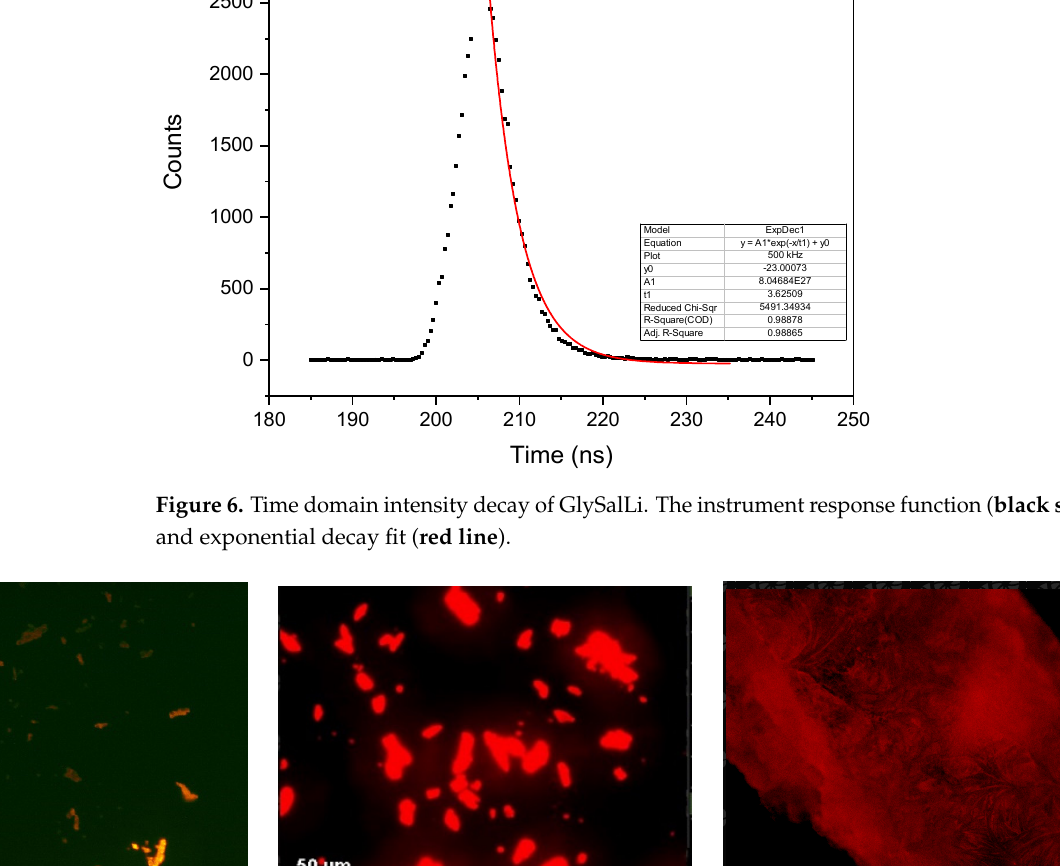
Figure 7. Confocal microscope images of GlySalX crystals ex green laser, blue and green light fil- tered